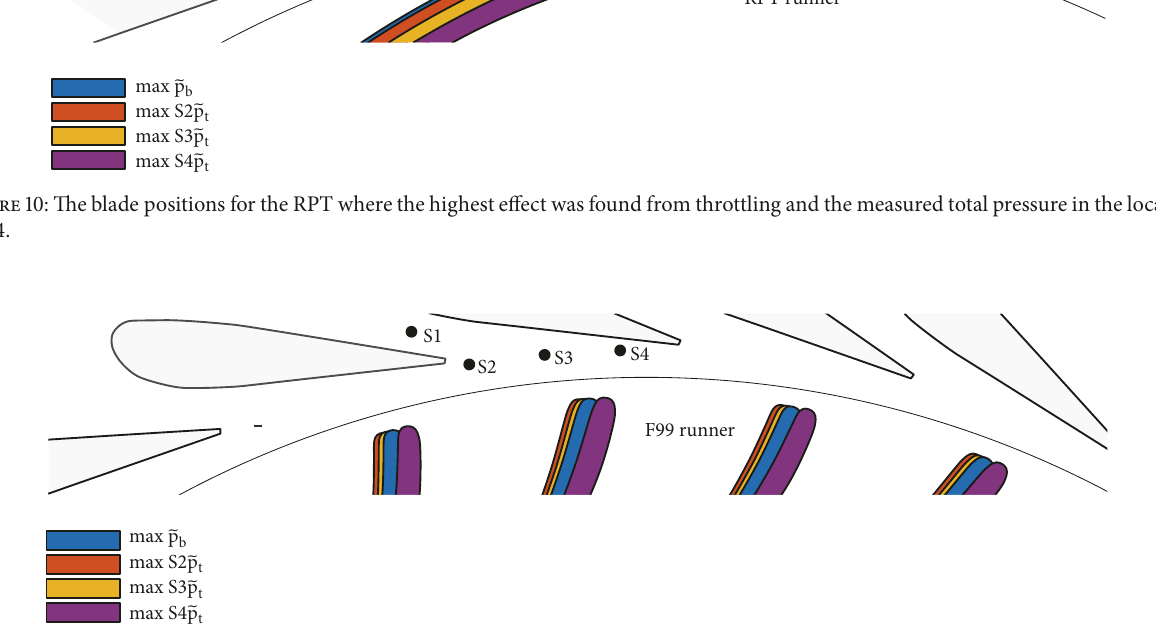
Figure 11: The blade positions for the F99 where the highest pressures were